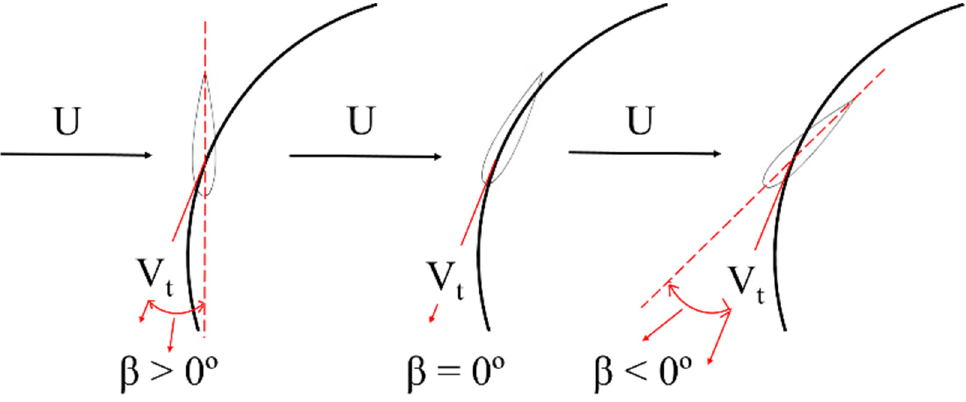
Figure 12. Definition of pitch angle ( β ).